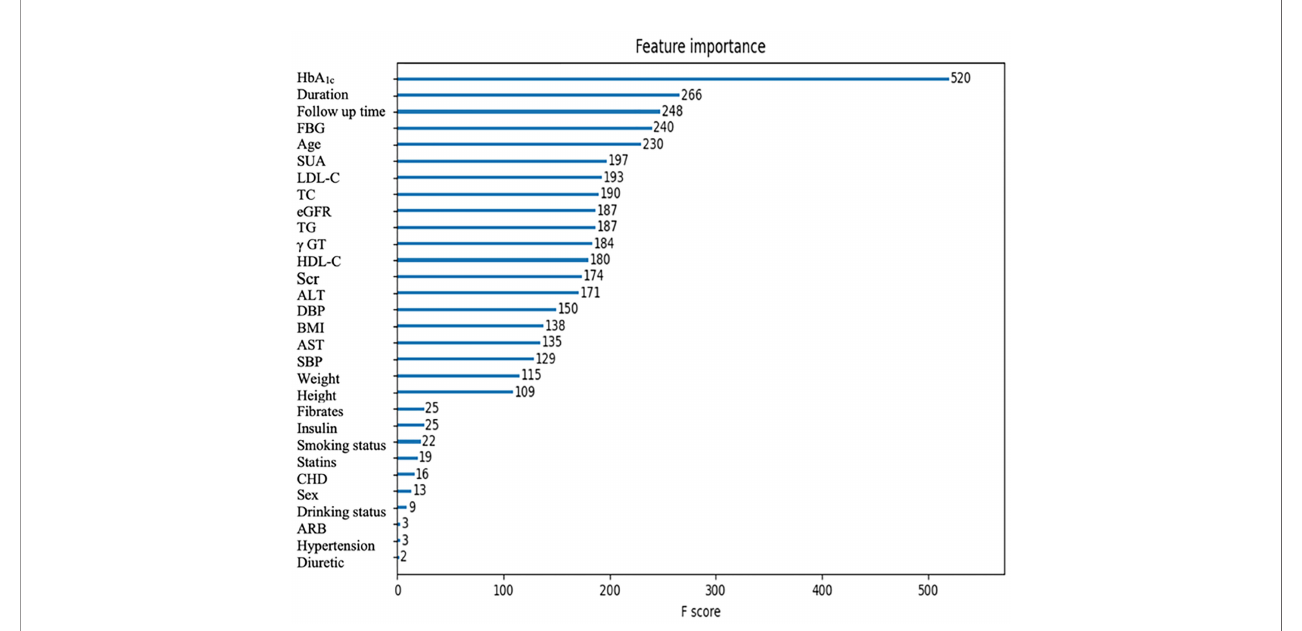
FIGURE 2 | The importance scores of the features calculated by